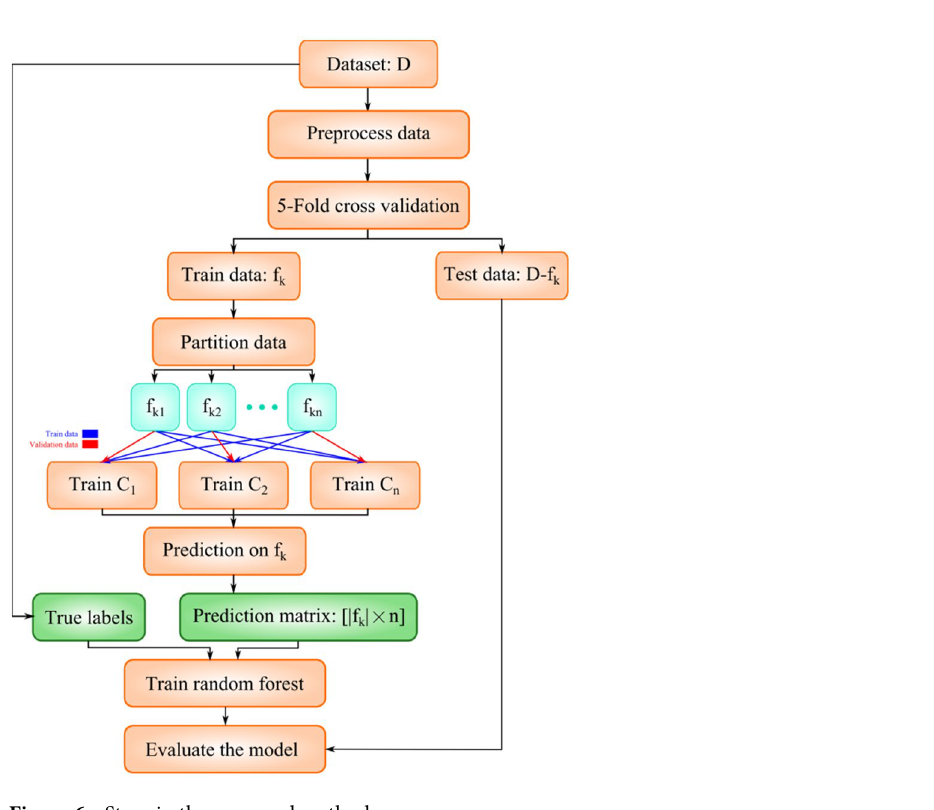
Figure 6. Steps in the proposed